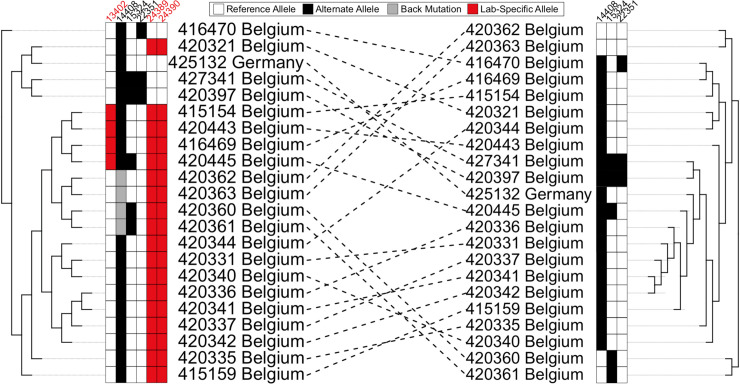
Lab-associated variants impact phylogenetic inferences.Part of the tree we obtained from the 4/19/2020 Nextstrain tree (left) compared to the corresponding part of tree after removal of sites with lab-associated variants (right). Lab-associated variants (red) can affect the inferred phylogeny and are associated with apparent back-mutation to the ancestral allele (grey in column 14408, left) at other sites (white). When lab-associated variants are removed, the resulting tree (right) shows no evidence for back-mutation at those sites (now white in column 14408), though several independent forward mutations remain evident.